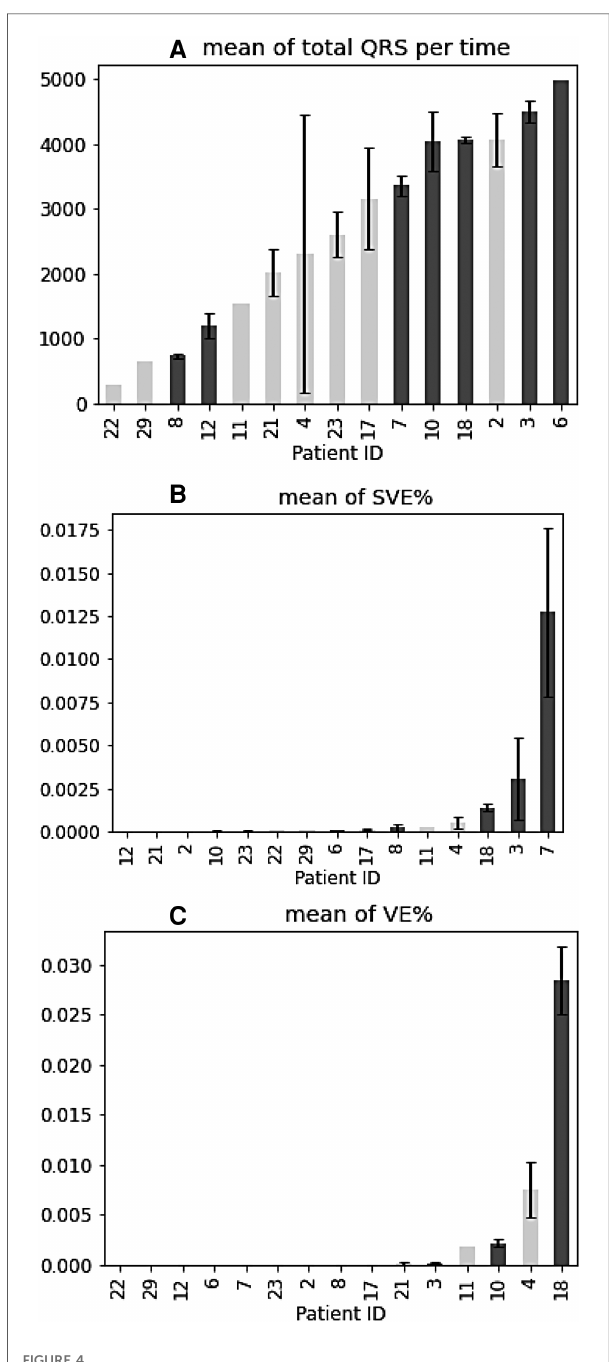
FIGURE 4 Mean of QRS complexes, SVE%, and VE% for all patients. ( A – C ) Patients with arrhythmia are shown in blue. Error bars indicate±standard error of the